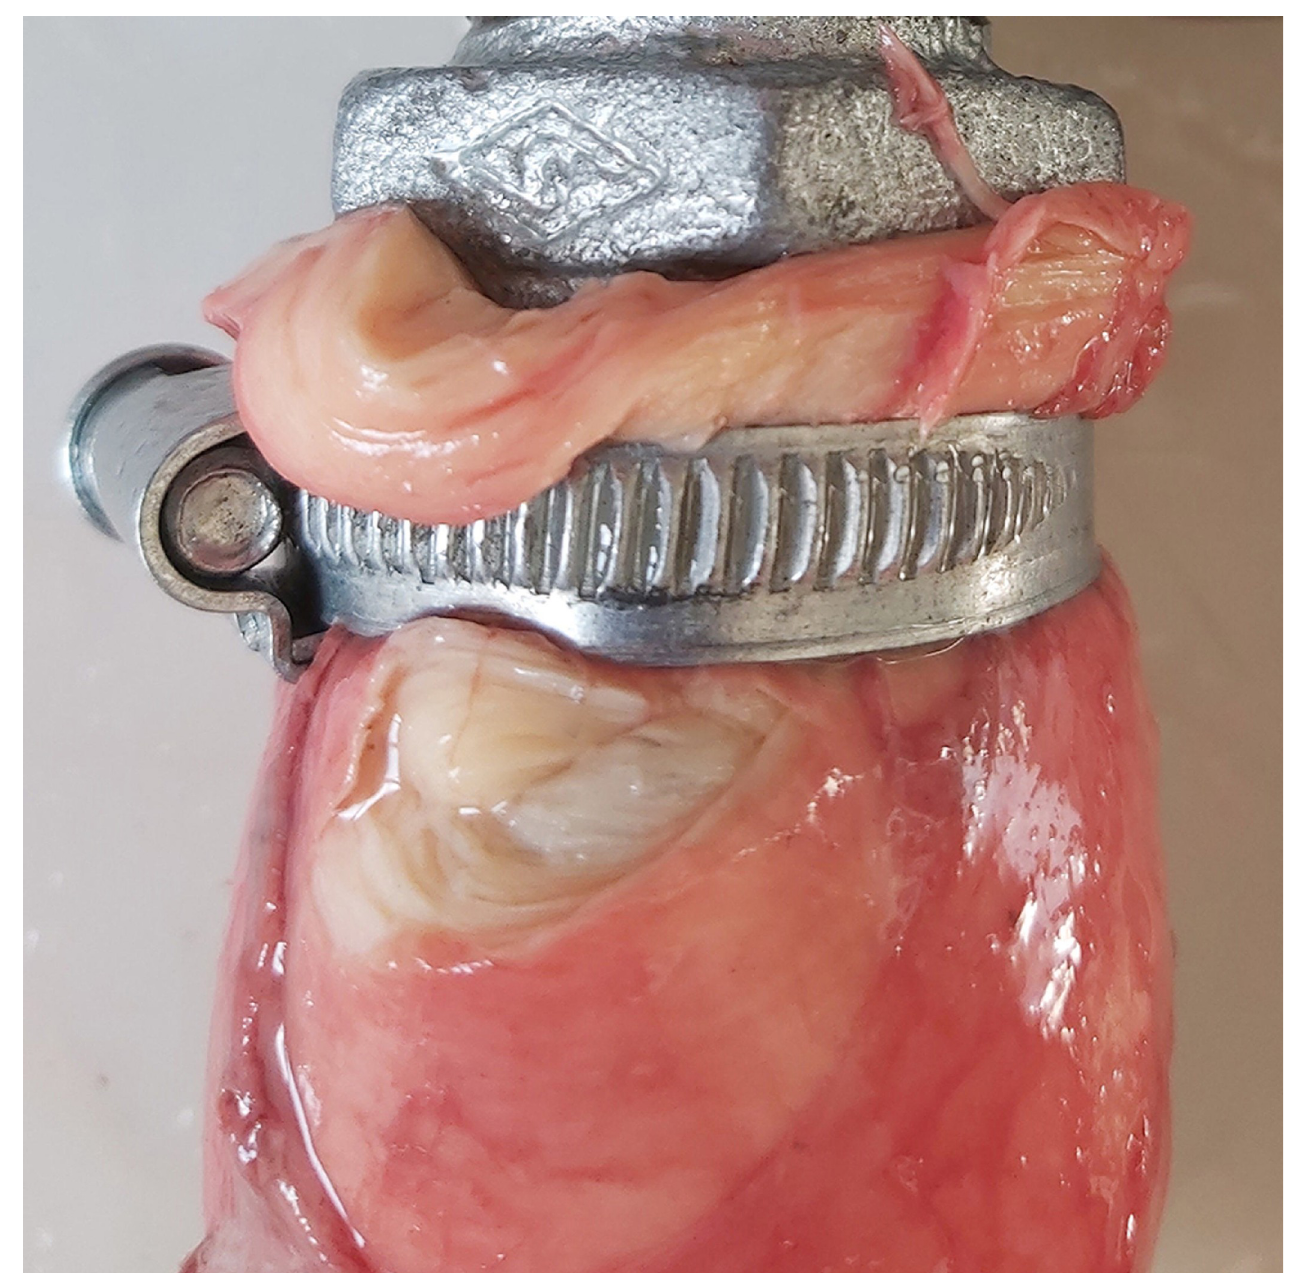
Fig 7. Typical cross-sectional rupture of the proximal aorta, close to the mounting side, which occurred predominantly in older horses ( > 15 years) at high pressures (250–300 mmHg).